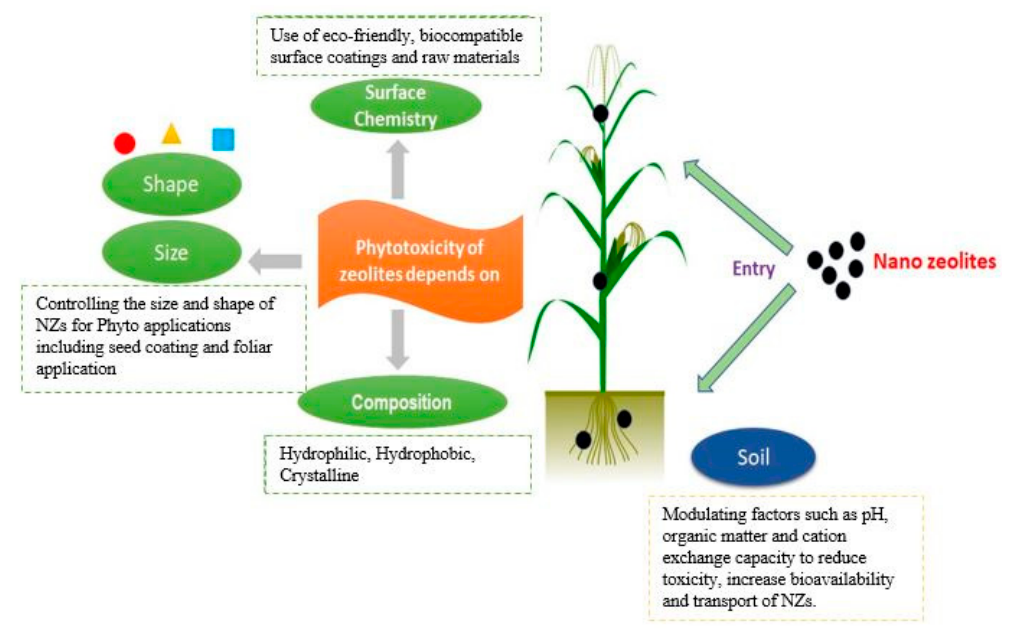
Figure 6. Introduction of nano-zeolites and their potential effects.